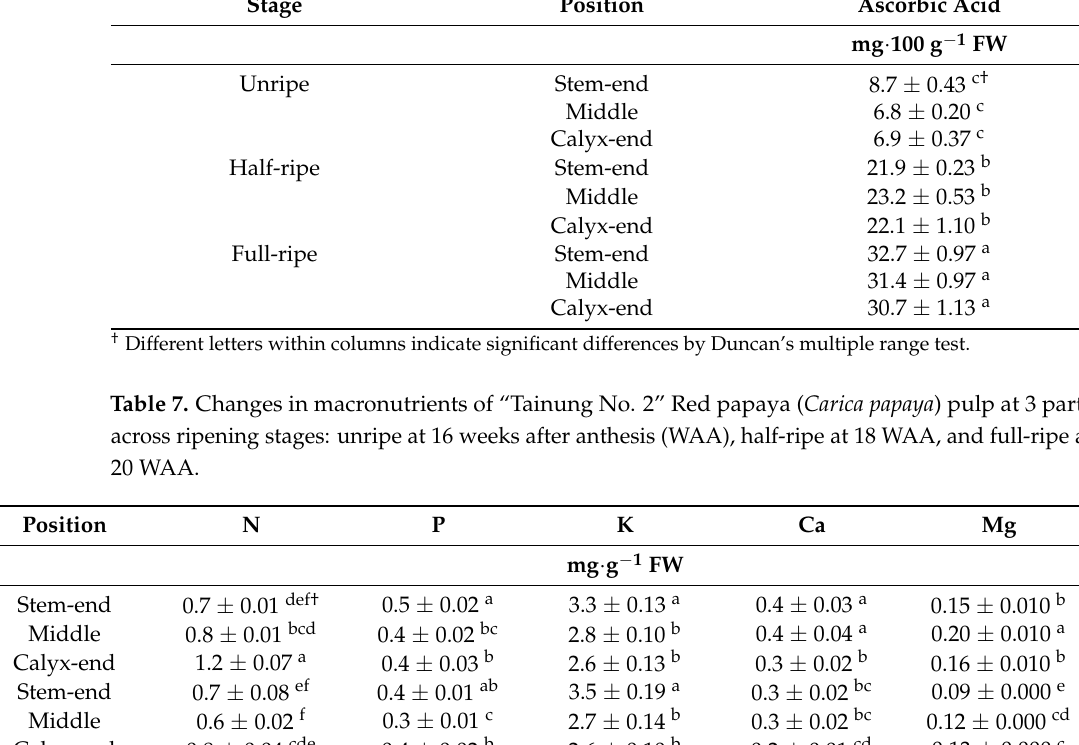
Table 6. Changes in the content of ascorbic acid at each part of “Tainung No. 2” Red papaya ( Carica papaya ) pulp at 3 parts across ripening stages: unripe at 16 weeks after anthesis (WAA), half-ripe at 18 WAA, and full-ripe at 20 WAA.